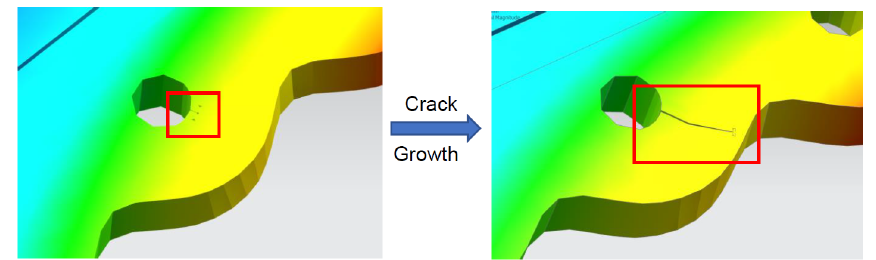
Figure 16. Through hole crack growth behavior.